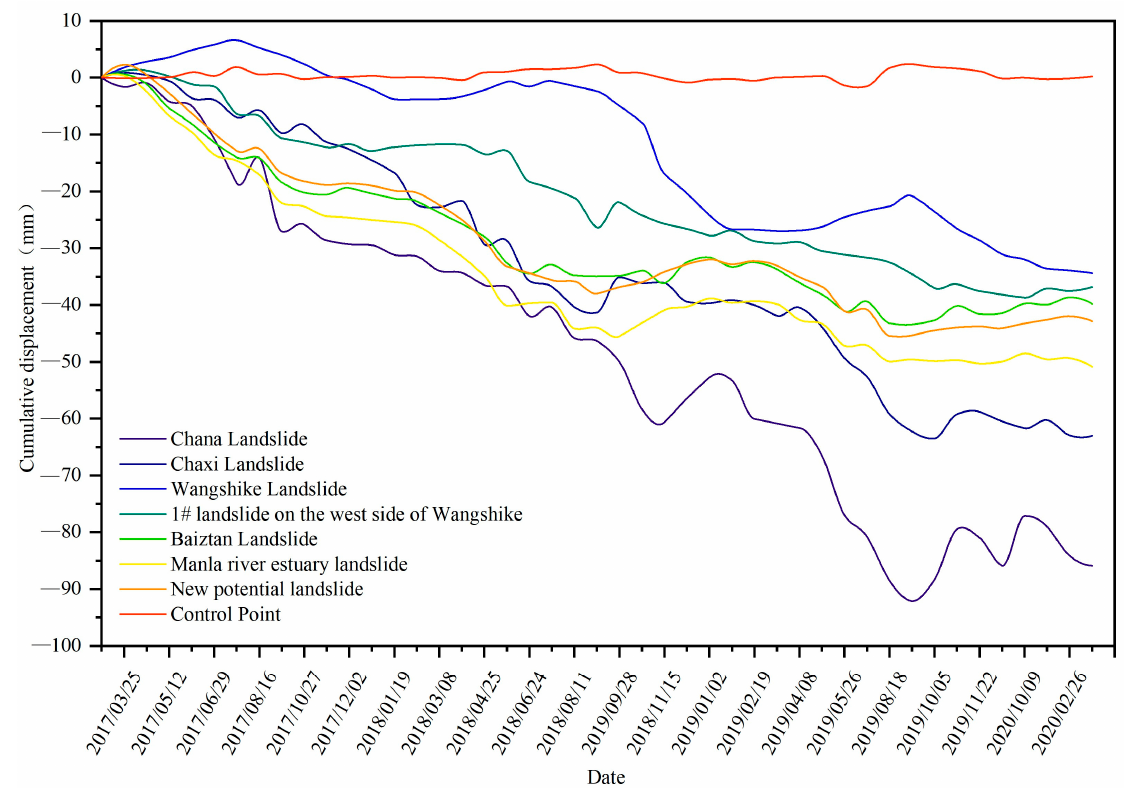
Figure 9. Cumulative displacement of landslides in the Longyangxia Reservoir